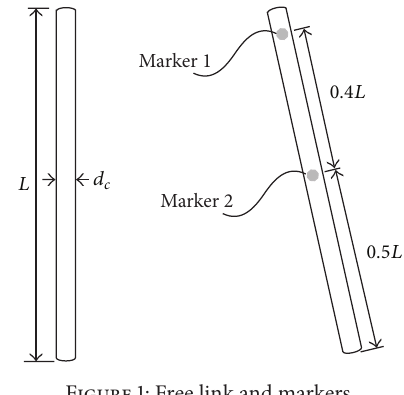
Figure 1: Free link and markers.